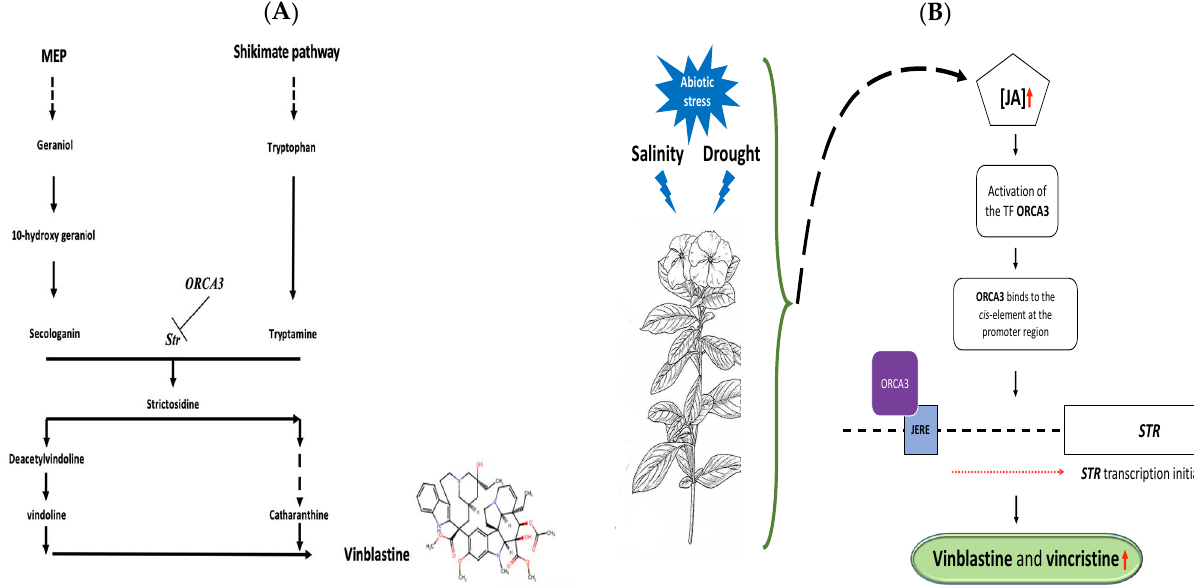
Figure 2. ( A ) The vinblastine biosynthetic pathway. ( B ) Jasmonic acid elicitation of vinblastine in Catharanthus rouses . JA content is increased when the plant is exposed to salinity or drought stress or both together. Then, the AP2/ERF TF known as ORCA3 is activated and binds to the regulatory cis -element (JERE) that is found upstream of the STR gene that encodes for a key regulatory enzyme in the vinblastine biosynthesis pathway.